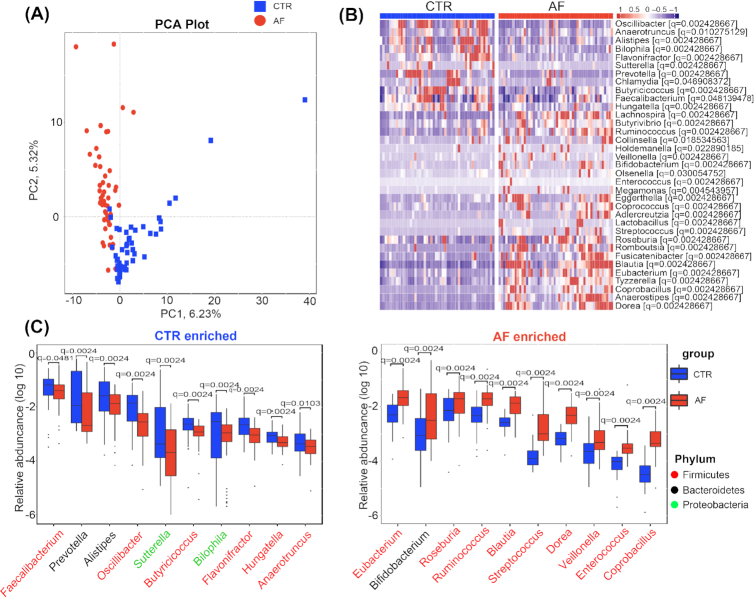
Genera strikingly different across groups. A, PCA based on abundances of the microbes showed that the structures of gut microbiota in AF were significantly different from controls (CTR) at the genus level. B, Relative abundance of the top 35 most different genera across groups at the criteria of q value <0.05 (comparisons presented in the square brackets); Wilcoxon rank sum test. The abundance profiles are transformed into z scores by subtracting the average abundance and dividing the standard deviation of all samples. z score is negative (shown in blue) when the row abundance is lower than the mean and red when the row abundance is higher than the mean. C, The box plot shows the relative abundance of the top 10 genera enriched in controls and AF participants. Boxes represent the interquartile ranges, lines inside the boxes denote medians, circles are outliers, and q (adjusted P) value is shown at the top of the box; Wilcoxon rank sum test.